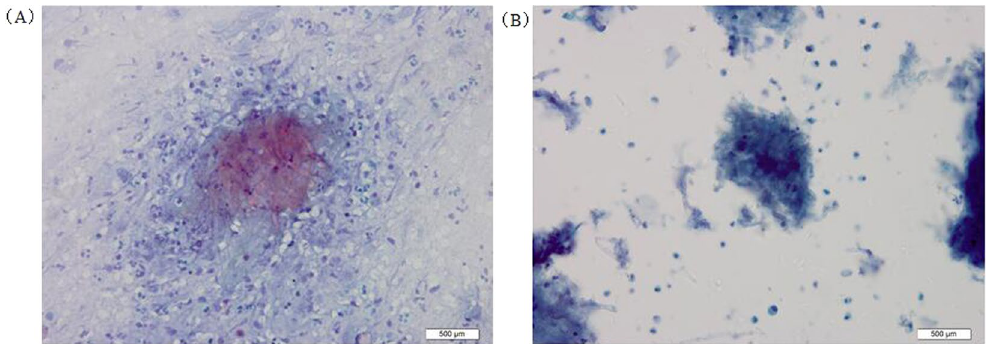
Figure 4. Cytomorphology of “branched ashes-like necrosis” in bronchial brushing samples processed using the SurePath LCT platform or conventional cytopathology, followed by Papanicolaou’s staining. Necrosis in the pattern of “branched ashes-like necrosis” appeared as wither-like ashes. Samples were stained with Papanicolaou’s stain. Magnification, 400X. ( A ) Conventional cytopathology on bronchial brushing samples; ( B ) LCT on bronchial brushing samples. LCT: Liquid-based